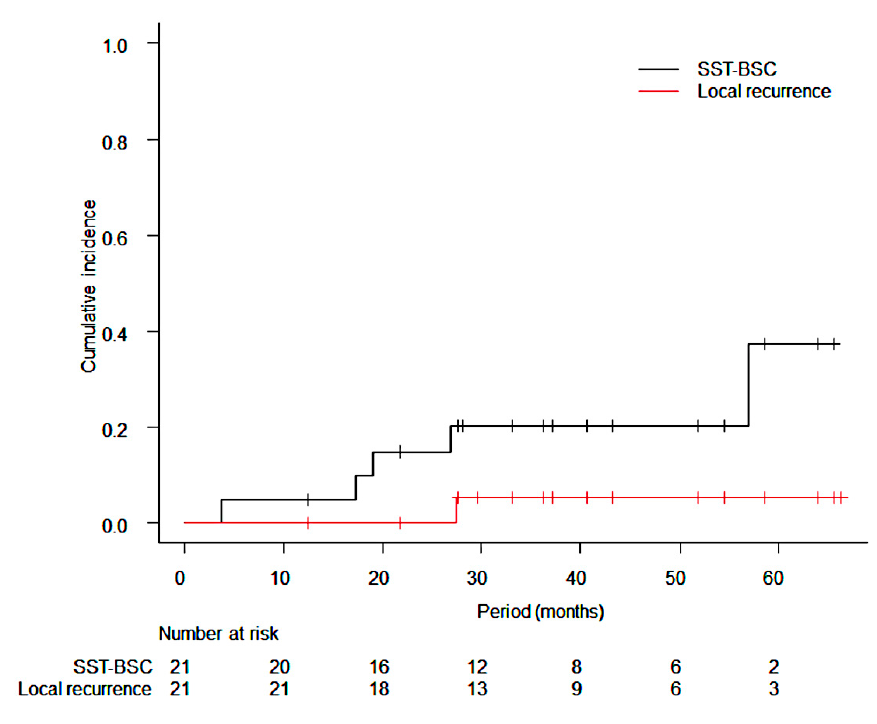
Figure 1. Cumulative incidence rates of local recurrence and percentage of patients who received systemic therapy or best supportive/palliative care (SST-BSC). The 1-year, 2-year and 3-year local recurrence rates were 0.0%, 0.0%, and 5.3%, respectively. The 1-year, 2-year, and 3-year SST-BSC rates were 4.8%, 14.8%, and 20.1%, respectively.